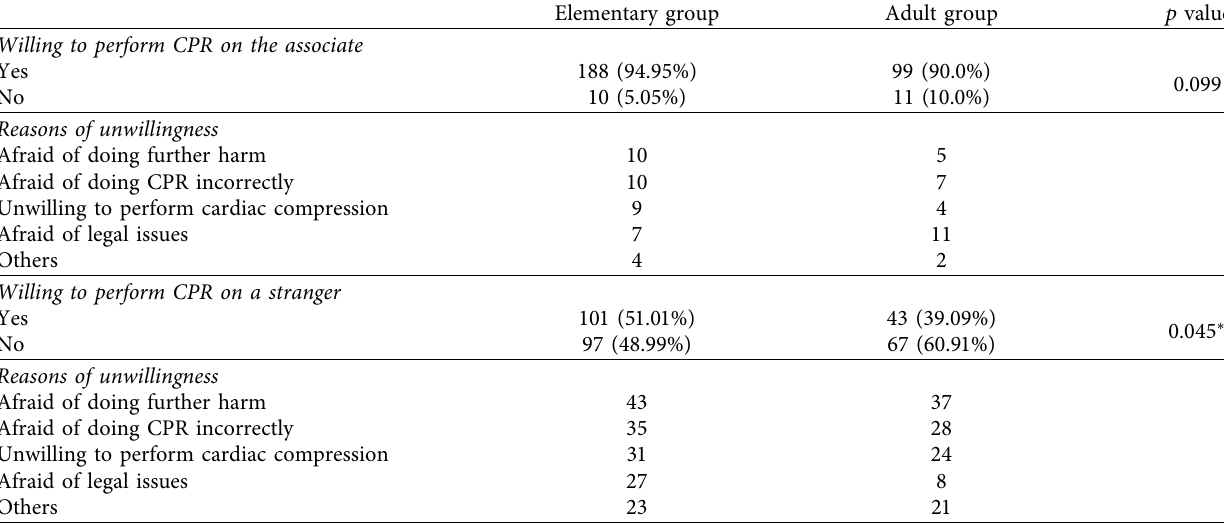
Table 4: Willingness to perform CPR after